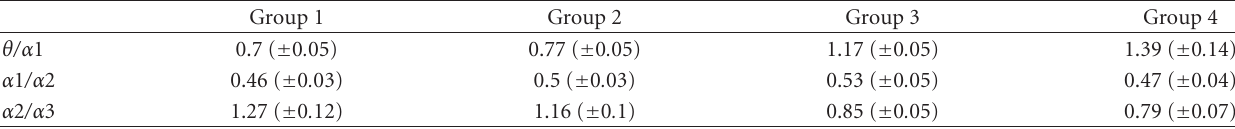
Table 2: Mean values ± standard error of theta/alpha1, alpha1/alpha2, and alpha2/alpha3 ratios in the MCI subgroups. Group 1: no vascular damage; group 2: mild vascular damage; group 3: moderate vascular damage; group 4: severe vascular damage.